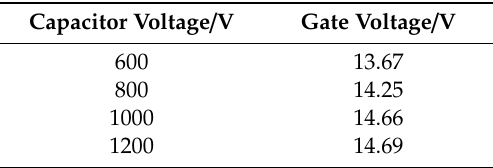
Table 2. Peak voltage of the G-GR at different capacitor voltages.